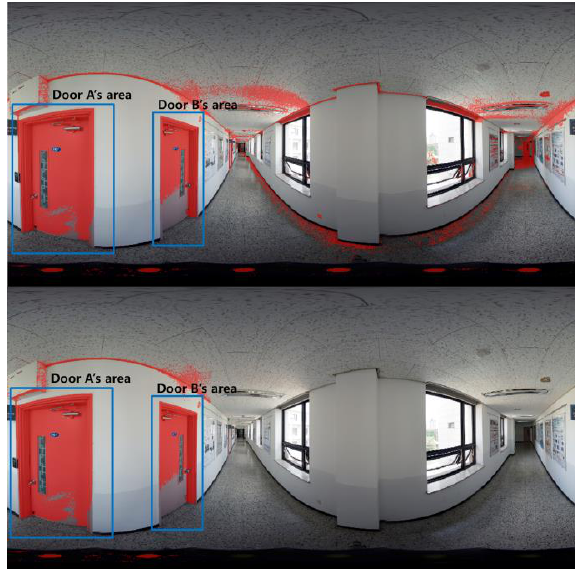
Figure 4. Image classification using the door’s colour (top: without ROI, bottom: with